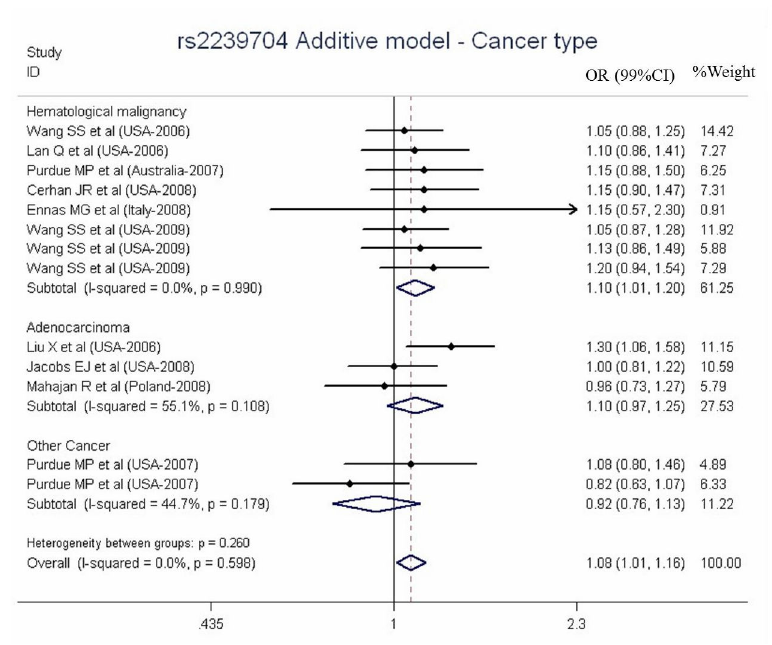
Figure 3. Meta-analysis of LTA rs2239704 polymorphism and cancer risk stratified by cancer type.